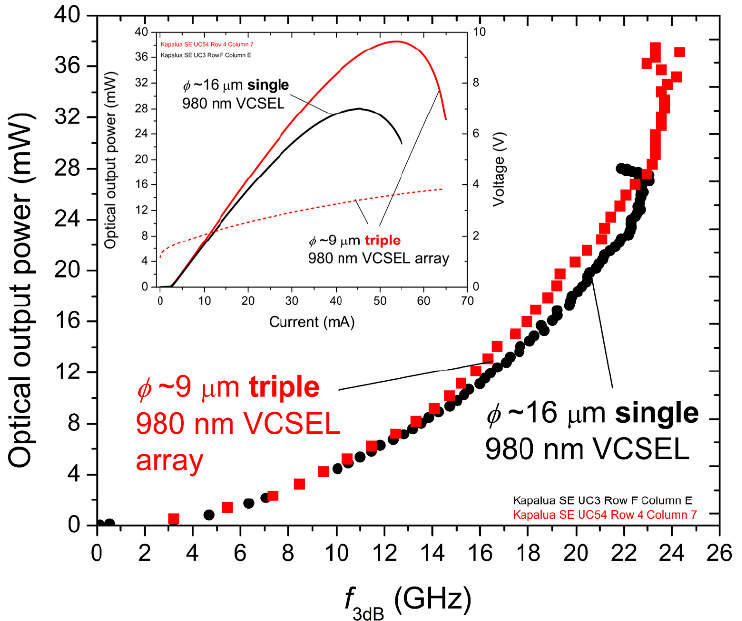
Figure 13. Extracted bandwidth f 3dB versus static optical output power ( L ) for a reference 980 nm single VCSEL with φ ~16 µ m (black circles) and for a 980 nm triple VCSEL array with φ ~9 µ m (red squares). Inset: the corresponding LIV curves. The emitting areas of the single VCSEL and the triple VCSEL array are approximately equal. The maximum f 3dB for the single φ ~16 µ m VCSEL is ~23 GHz. The maximum f 3dB for the triple φ ~9 µ m VCSEL array is ~24 GHz.